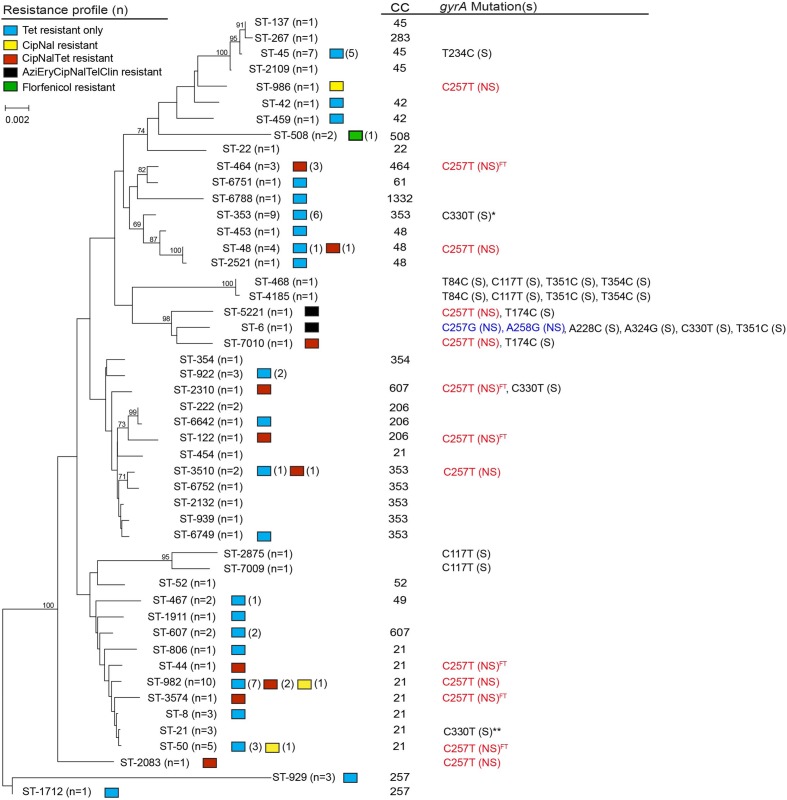
Neighbor-joining phylogeny of sequence types (STs) by antimicrobial resistance patterns, clonal complexes (CCs), and type of gyrA mutation. The numbers at the end of each branch represent the STs found in this study, while the numbers at the nodes represent the bootstrap value from 1,000 replications. Non-synonymous mutation is noted by NS in parentheses; S in parentheses indicates synonymous mutation. Superscript FT indicates isolates recovered from a case with foreign travel history. gyrA mutations were determined using C. jejuni ATCC 33560 as the reference; location 243, 357, 360 were defined as CT variable regions. *6 of 9 isolates had a synonymous point mutation at C330T. **1 of 3 isolates had a synonymous point mutation at C330T.